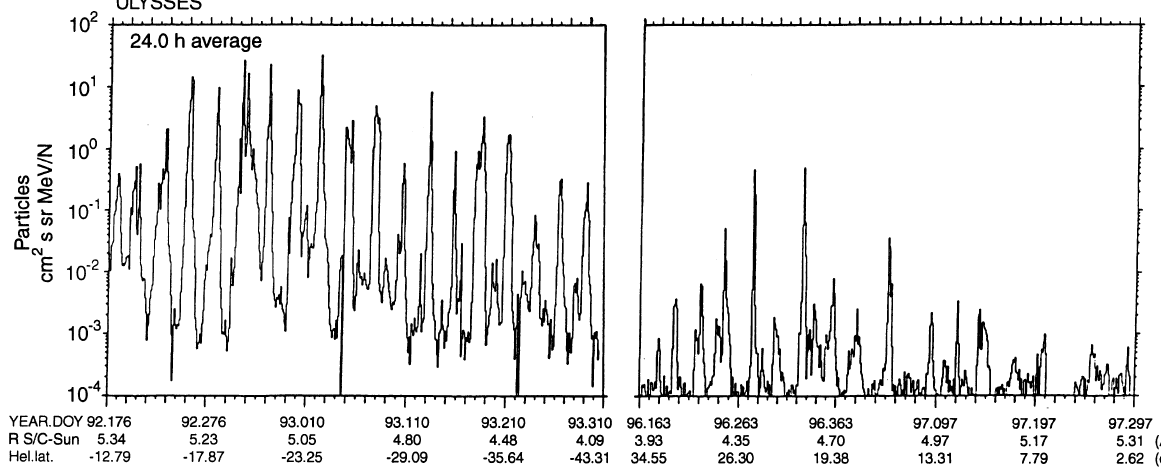
Fig. 1. Helium ion fluxes (0.4 E/N 1.6 MeV/N) versus time as measured by the ULYSSES-EPAC